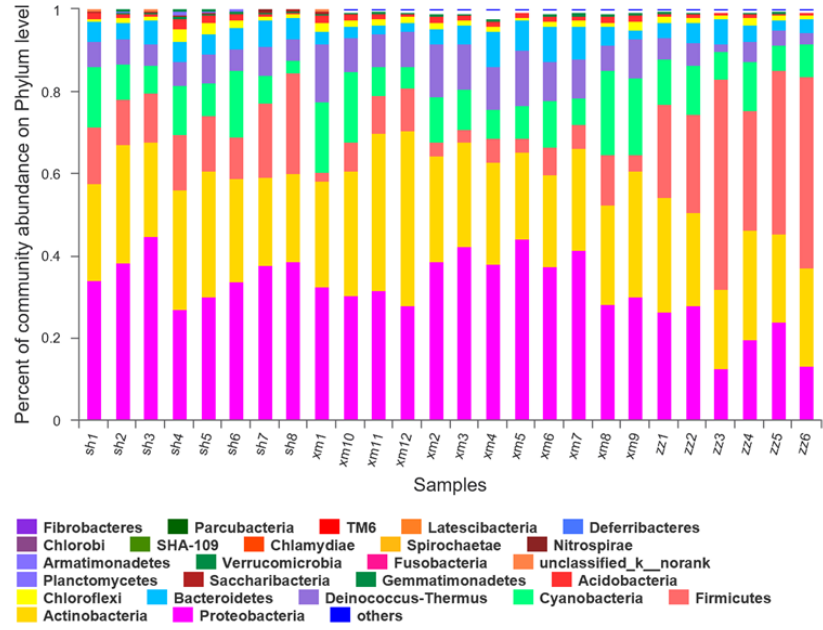
Figure 6. Composition of bacterial community structure in 26 samples at the phylum level. (sh: Shanghai; xm: Xiamen; zz: Zhangzhou).